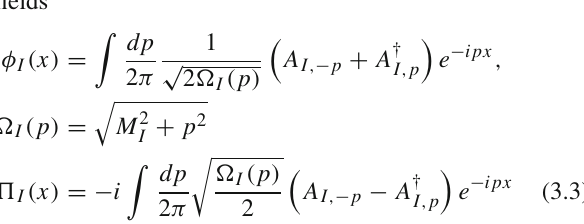
Fig. 3 The probability density P ( x , t ) at time t = 100 , 200 , 400 , 800 , 1600 and 3200 in red, green, blue, black, brown and magenta respectively. As expected, neutrinos oscillate more at later